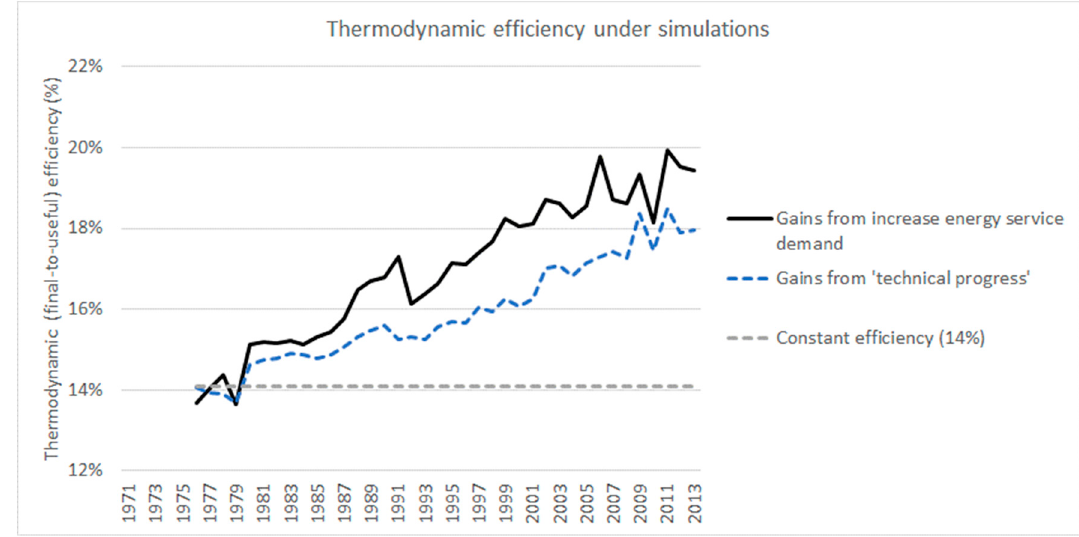
Figure 4. Thermodynamic efficiency gains from technical progress and increased energy services.